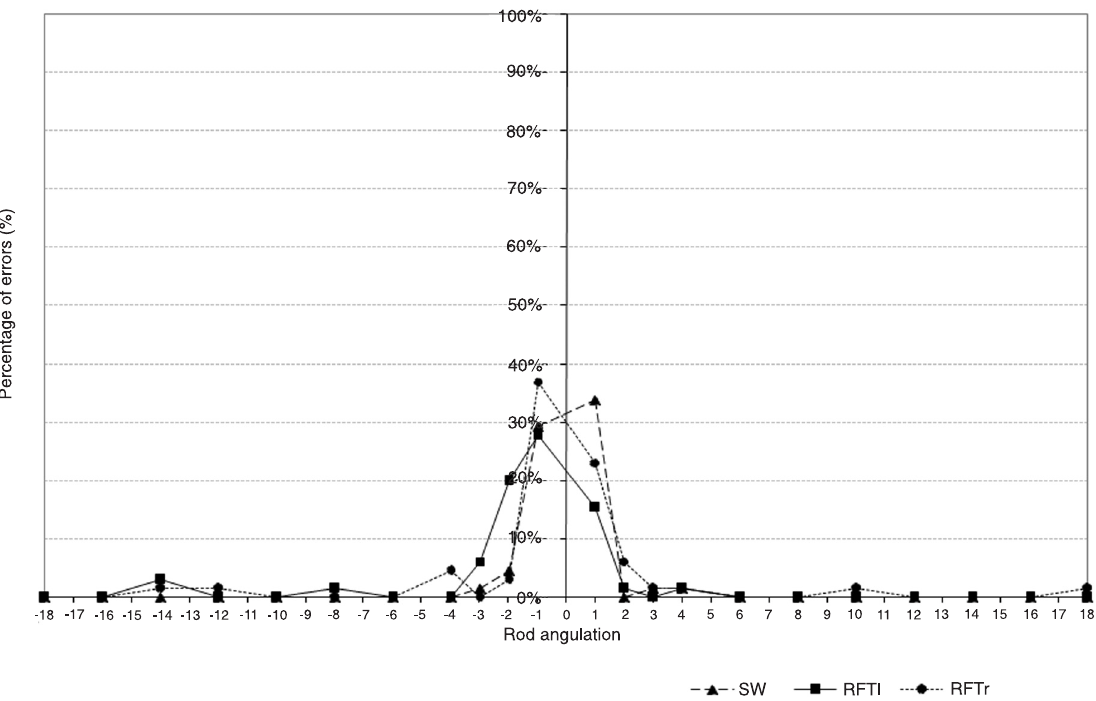
Figure 5. Percentage of errors per rod angle in SVV and RFT in field-independent subjects (N = 14). SVV = subjective visual vertical; RFTl = rod and frame test, frame tilted to the left; RFTr = rod and frame test, frame tilted to the